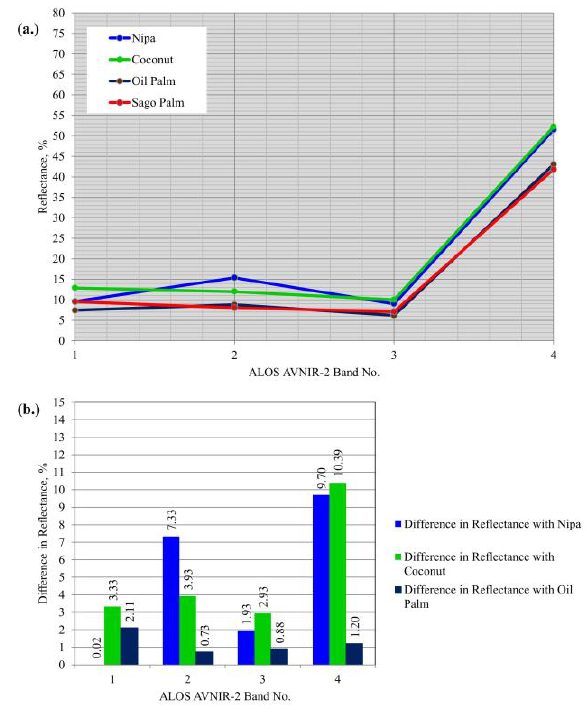
Figure 7. (a.) Resampled in-situ reflectance values of Sago and other palms in Bands 1-4 of ALOS AVNIR2; (b.) Difference in resampled in-situ reflectance of Sago with those of other